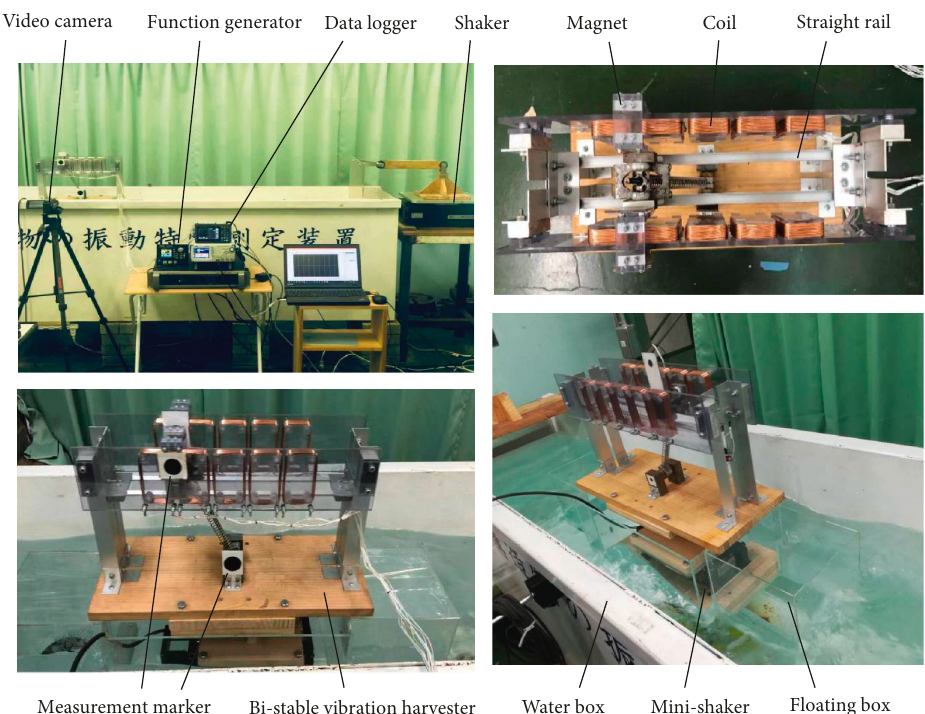
Figure 2: Photographs of experimental settings of bistable vibration power generation system.